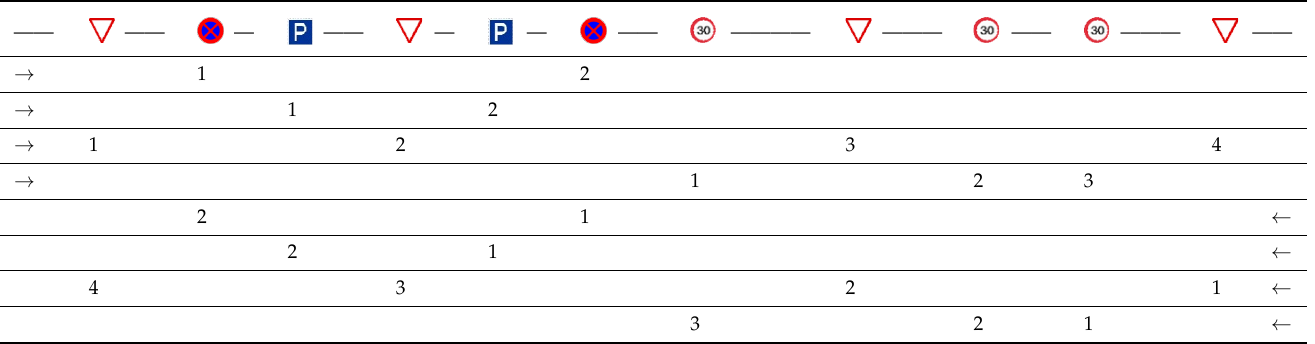
Table 2. A synthetic sequence of TSs used in the examples (top band), and the unified counts for the No stopping (NS), Parking lot (PL), the Give way (GW), and Max speed 30 km/h (SL) TSs in case of trips starting from the left and from the right, respectively (middle and bottom bands).